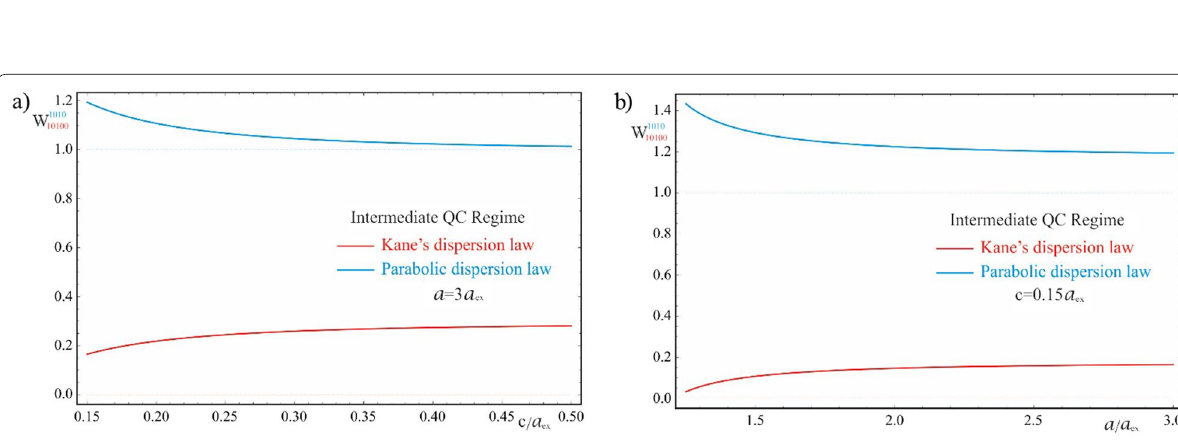
Fig. 15 The dependences of the AE for Kane’s and parabolic dispersion laws of CCs in the intermediate quantum confinement regime: ( a ) on the minor semiaxis c at the fixed value of the major semiaxis a , ( b ) on the major semiaxis a at the fixed value of the minor semiaxis